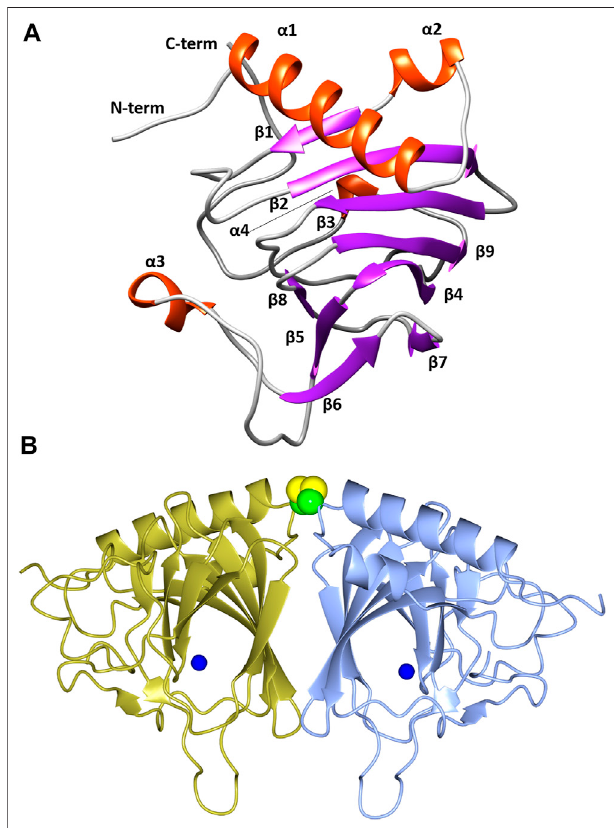
FIGURE 5 | (A) A cartoon representation of the TsLI monomer with the secondary structure elements labelled. Figure was prepared with UCSF Chimera(Pettersen etal.,2004). (B) Acartoonrepresentationofthecupinfold architectureoftheTsLIdimer.Theboundmanganeseionsareshownas blue spheres and the disul fi de bond between the cysteines C22 of each monomer are shown as a space fi lling model. Figures 5B , 8 – 12